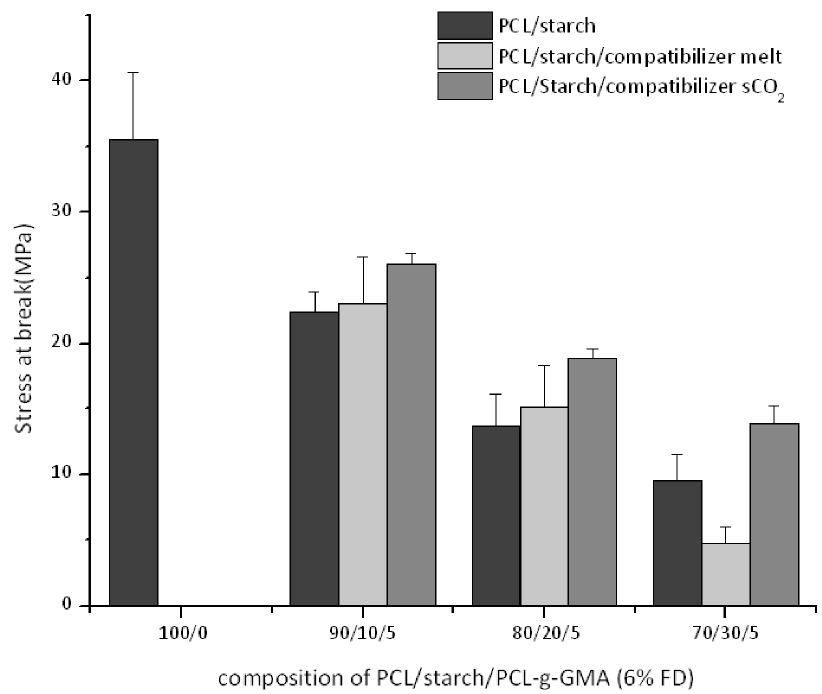
Figure 10. Stress at break for ternary PCL/Starch/PCL- g -GMA blends.